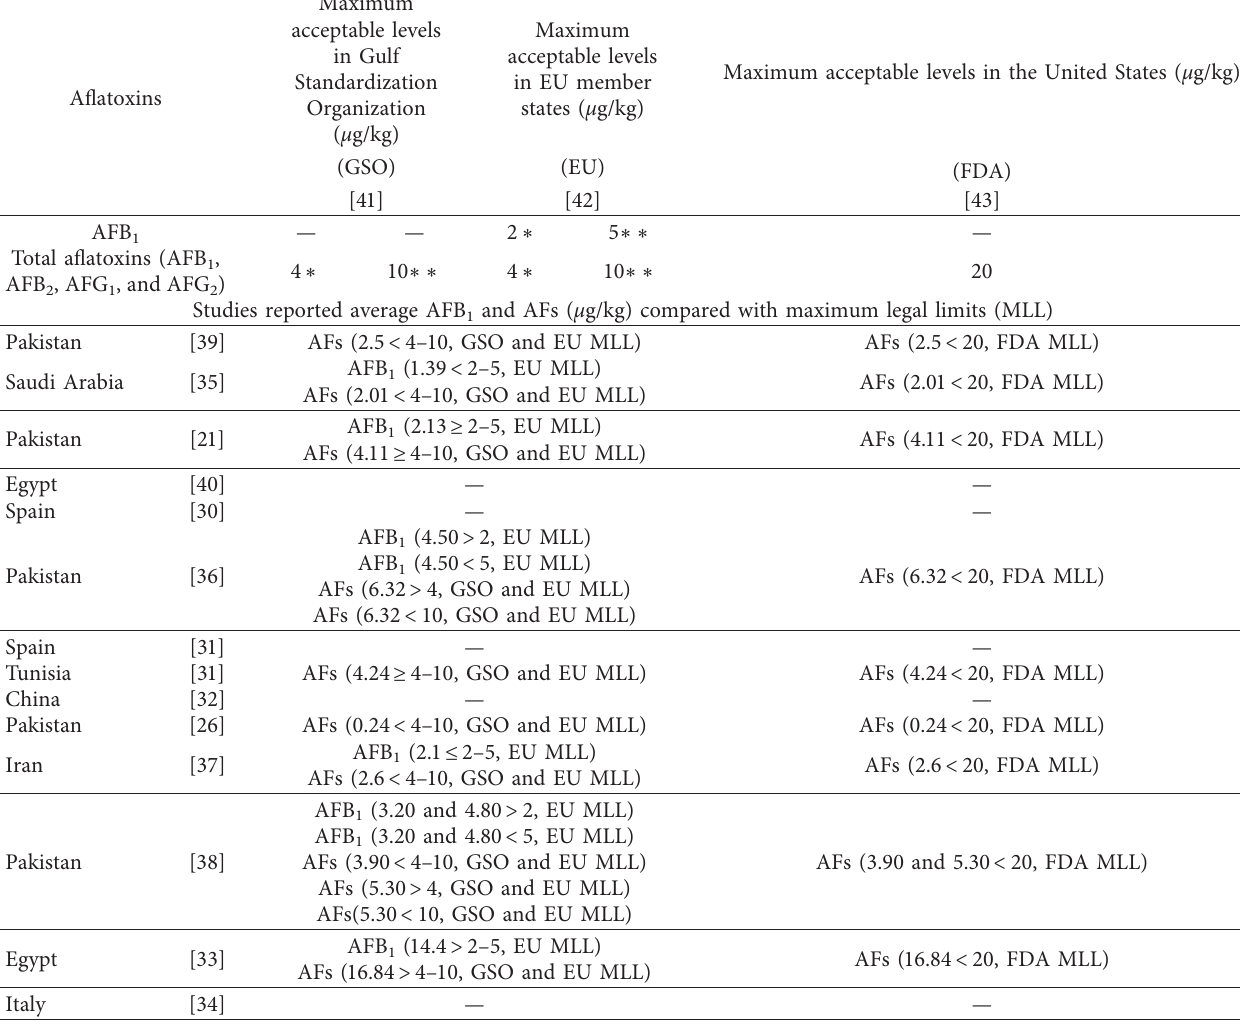
Table 2: Legal limits for aflatoxins of dried fruit in gulf standardization organization, European Union member states, and the United States, compared with the studies reporting the occurrence of aflatoxins in date palm